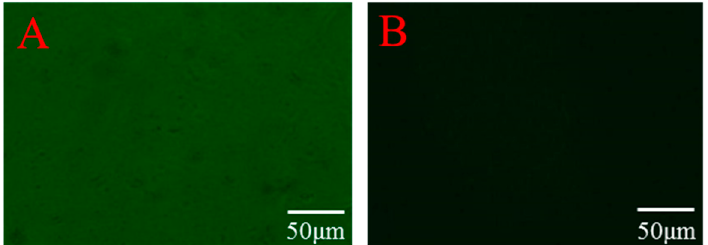
Figure 2. The fluorescence microscope images of the CaAlg hydrogel membrane before ( A ) and after ( B ) eluted by Tris-HCl with the pH of 7.4. sodium alginate (NaAlg) concentration: 2.5 wt%, Copper wire diameter: 0.2 mm.